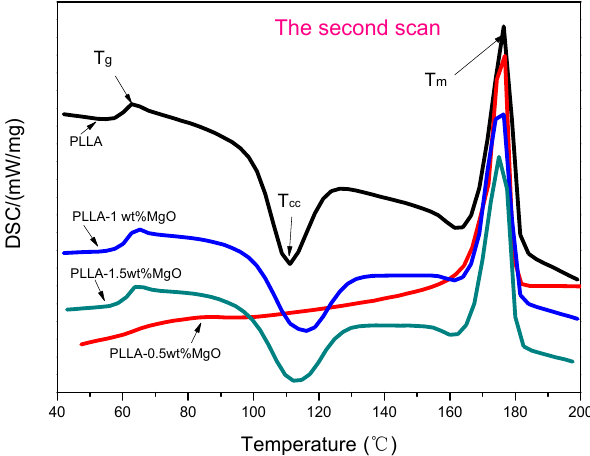
Figure 7. Differential scanning colorimetry (DSC) traces of PLLA, PLLA0.5, PLLA1 and PLLA1.5 for the secondary crystallization: the cooling rates are 5 °C/min and the heating rates are 10 °C/min.